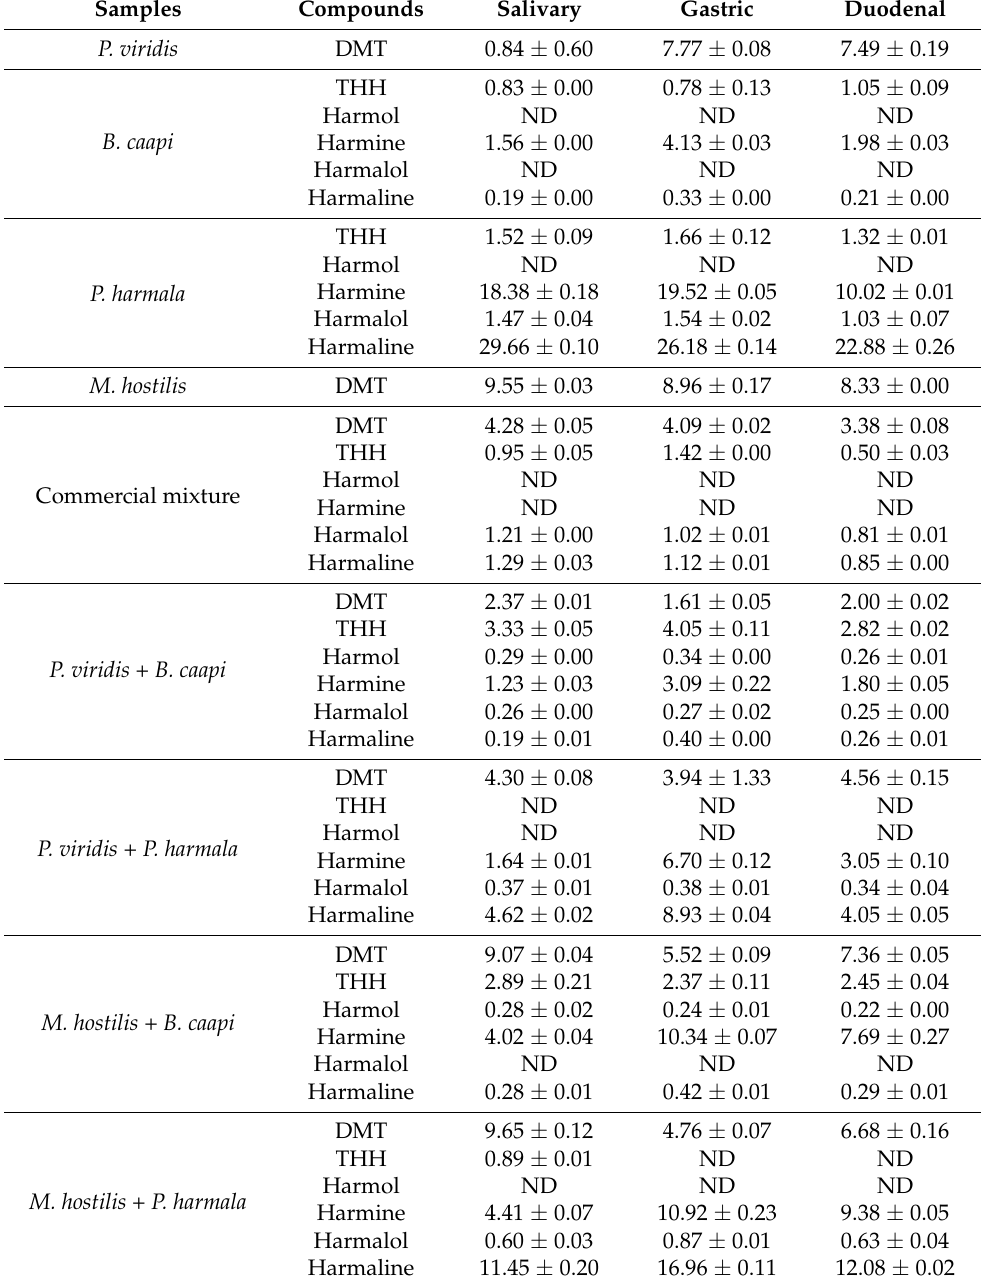
Table 2. Concentration of the main compounds of ayahuasca in different digestion steps. The values are expressed as mean ( µ g/mL) ±